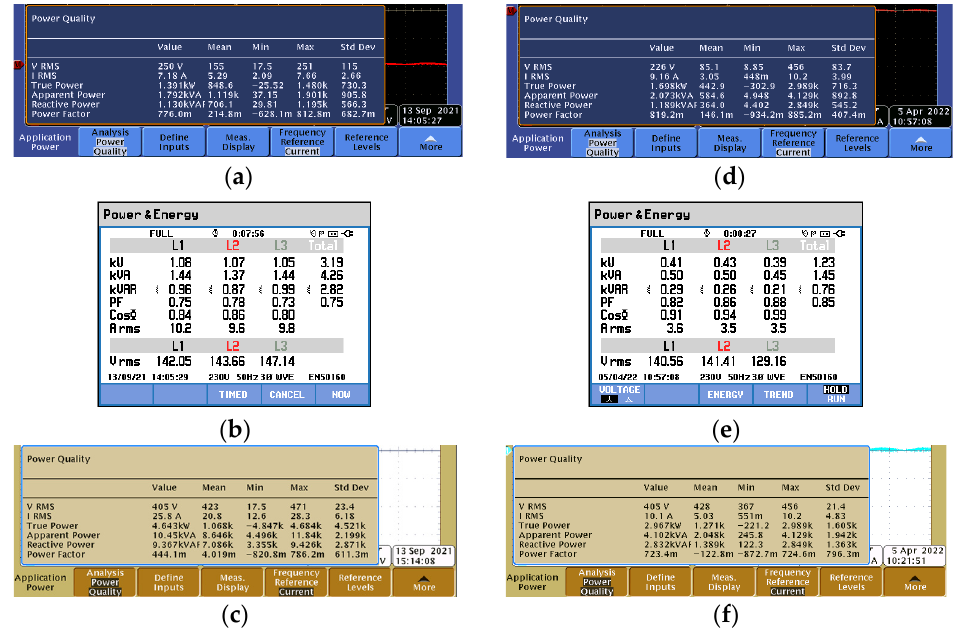
Figure 11. Dual-phase-inverter measured input and output powers: ( a ) measured single-phase output power; ( b ) measured output power delivered to the three-phase loads; ( c ) measured input power.